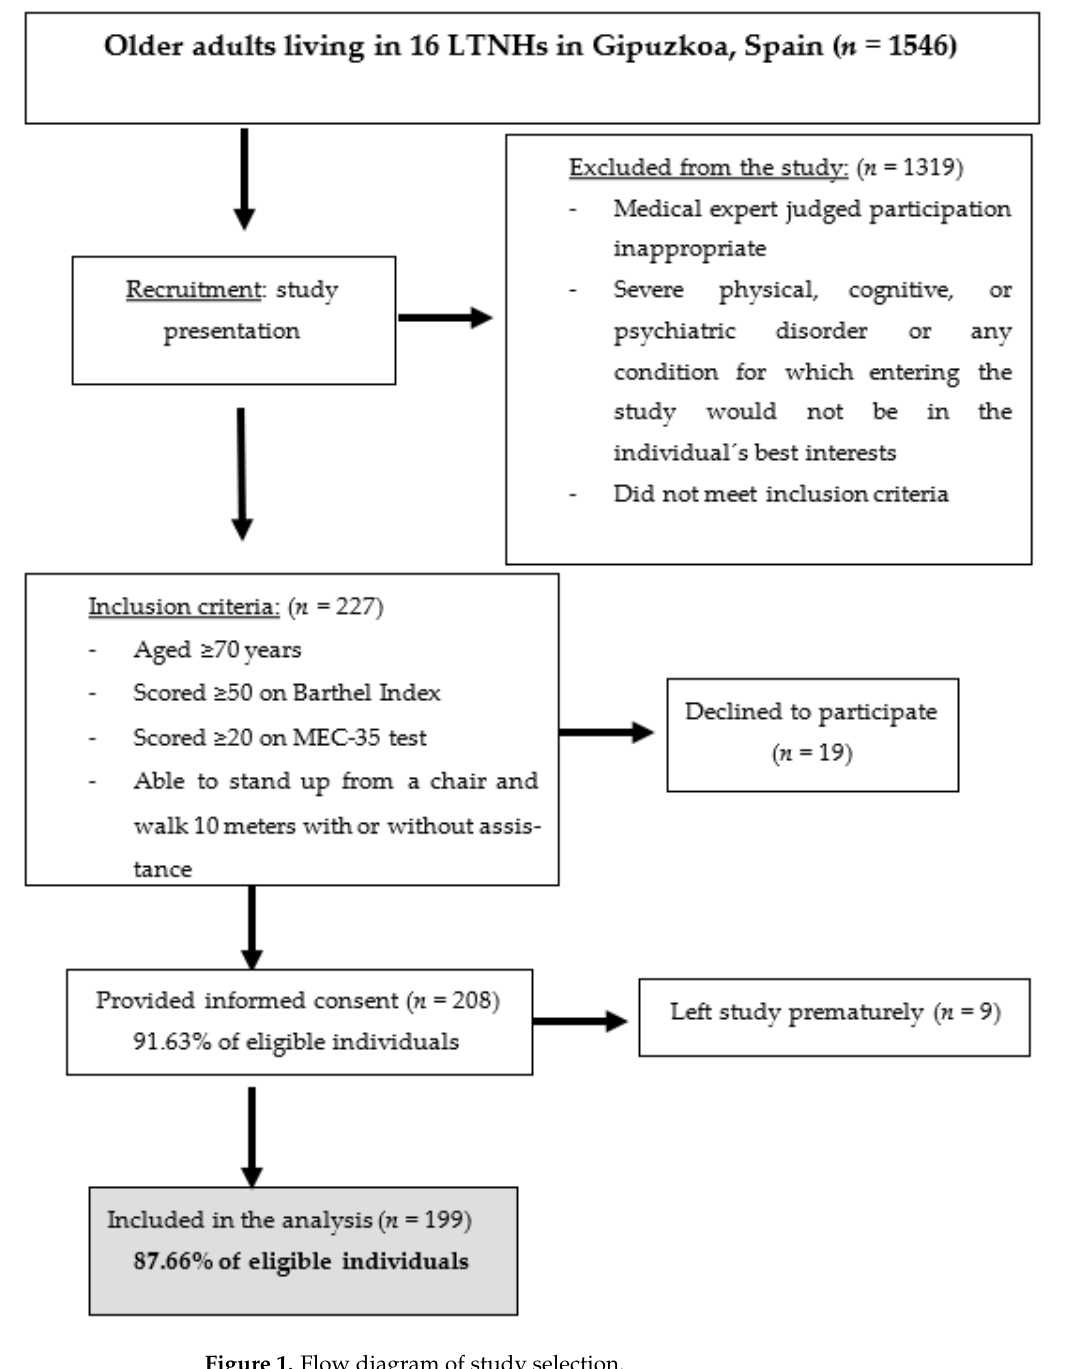
Figure 1. Flow diagram of study